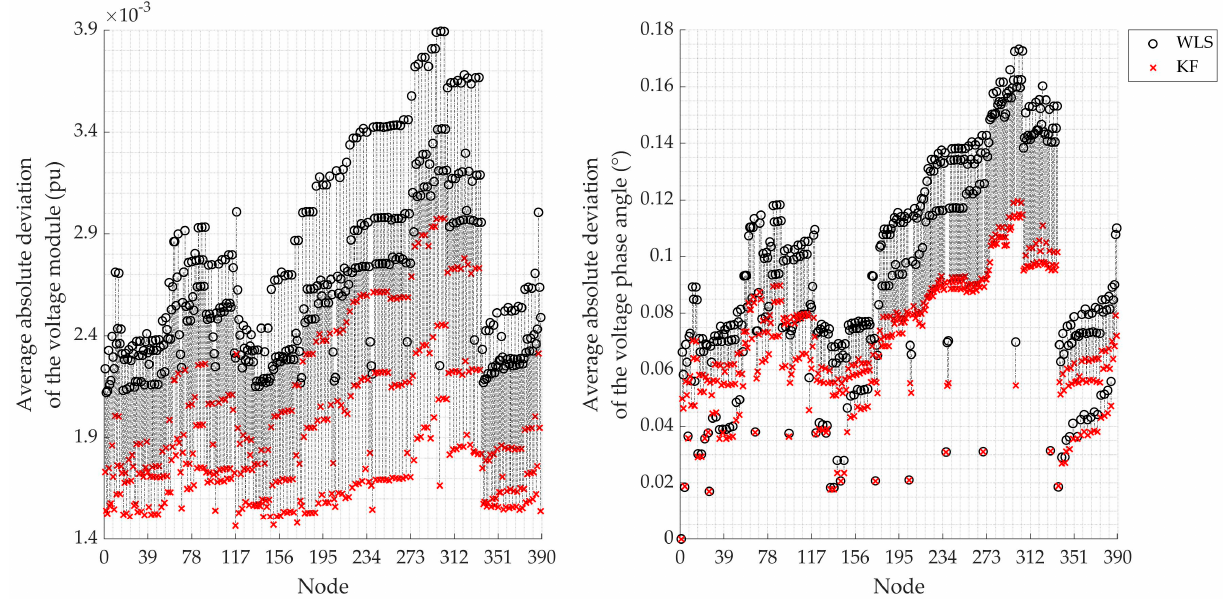
Figure 8. Average absolute deviation values for each node. Table 2. Total average absolute deviations for different SE methods.